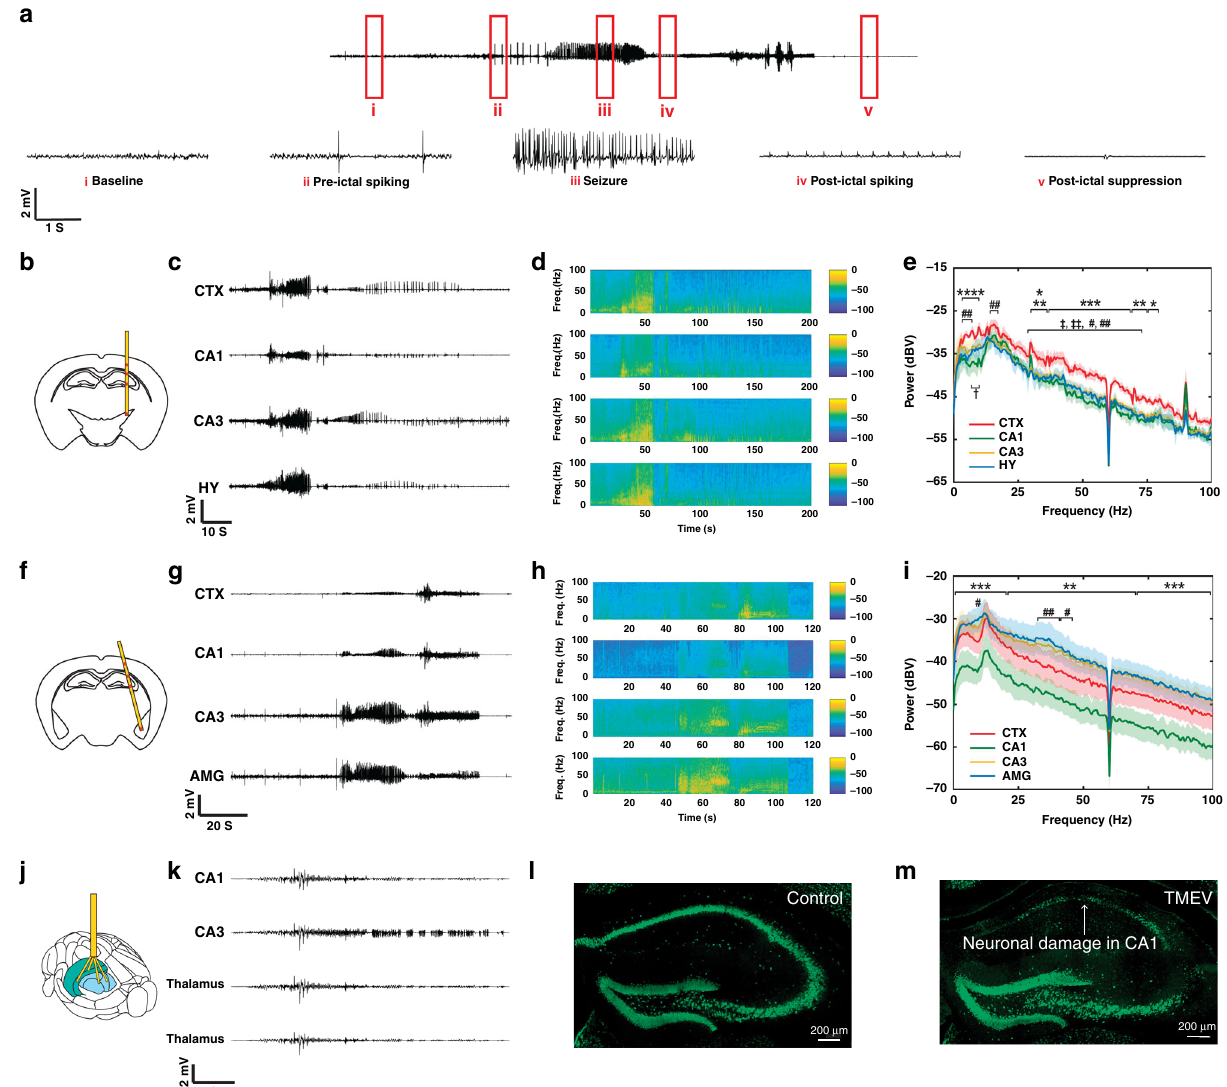
Fig. 5 Multisite recording of seizure activity in various brain regions in a mouse model of infection-induced epilepsy. a An example of electrographic recording by a fi ber probe implanted in the amygdala of a TMEV-infected mouse is shown. Various stages of mouse behavior before, during and after convulsive seizure are identi fi ed in red rectangles and the corresponding magni fi ed traces are depicted below: baseline (non-ambulatory physiological stage), pre-ictal spiking (periodic electrographic discharges before or during seizure initiation), seizure (high frequency spikings during fully generalized tonic-clonic seizure), post-ictal spiking (periodic electrographic discharges immediately after seizure), and post-ictal suppression (behavioral arrest following convulsive seizure). b Diagram of coronal section of a mouse brain shows the location of depth-dependent fi ber probes in cortex (CTX), CA1 and CA3 regions of the hippocampus, and hypothalamus (HY) as indicated by red marks along with the probe assembly (straight implant, n = 3). c , d Representative traces of electrographic recordings from CTX, CA1, CA3, and HY during a non-convulsive seizure and their corresponding frequency distribution (straight implant). e Power spectrum density plot for non-convulsive seizures show that mean power of signal recorded from CTX was signi fi cantly higher compared to mean power from other brain regions for various frequency bands between 1 – 100 Hz (two-way ANOVA, Tukey ’ s multiple comparisons test; CTX vs. CA1 – * p < 0.05, ** p < 0.01, *** p < 0.001, ****p < 0.0001; CTX vs. CA3 – ‡ p < 0.05, ‡‡ p < 0.01; CTX vs. HY – #p < 0.05, ## p < 0.01; n = 14 seizures). f Diagram of the coronal section of a mouse brain shows the location of depth-dependent fi ber probes in the cortex (CTX), CA1, CA3, and amygdala (AMG) as indicated by red marks along with the probe assembly (angular implant, n = 4). g , h Representative traces of electrographic recordings from CTX, CA1, CA3, and AMG during a convulsive seizure and their corresponding frequency distribution (angular implant). i Power spectrum density plot for convulsive seizures show signi fi cantly higher mean power of signal recorded from CA3, AMG, and CTX compared to that in CA1 between 1 – 100 Hz (Two-way ANOVA, Tukey ’ s multiple comparisons test; CA1 vs. CA3 and CA1 vs. AMG —†††† p < 0.0001; CA1 vs. CTX — ** p < 0.01, *** p < 0.001; n = 20 seizures). j Diagram of a mouse brain showing the location of two spatially expandable fi ber probes implanted in CA1 and CA3 regions of the hippocampus and the other two in the thalamus ( n = 3). k Similar to depth-dependent fi ber probes, representative traces of electrographic recordings from the hippocampus and thalamus obtained by spatially expandable fi ber probes indicate higher network activity in the CA3 region. l , m Immunohistochemical staining of nuclear neuronal protein (NeuN, in green) in brain slices shows the neuronal loss in the CA1 region of the TMEV-infected mouse with seizures ( m ) compared to the sham-injected control mice ( l ). The loss of neurons in the CA1 region may explain the lower power of electrographic activity detected by fi ber probes in CA1. Representative images are shown taken from ≥ 3 animals analyzed for each experimental group and were chosen to re fl ect the mean value of quantitative data. All shaded areas in the fi gure represent the standard